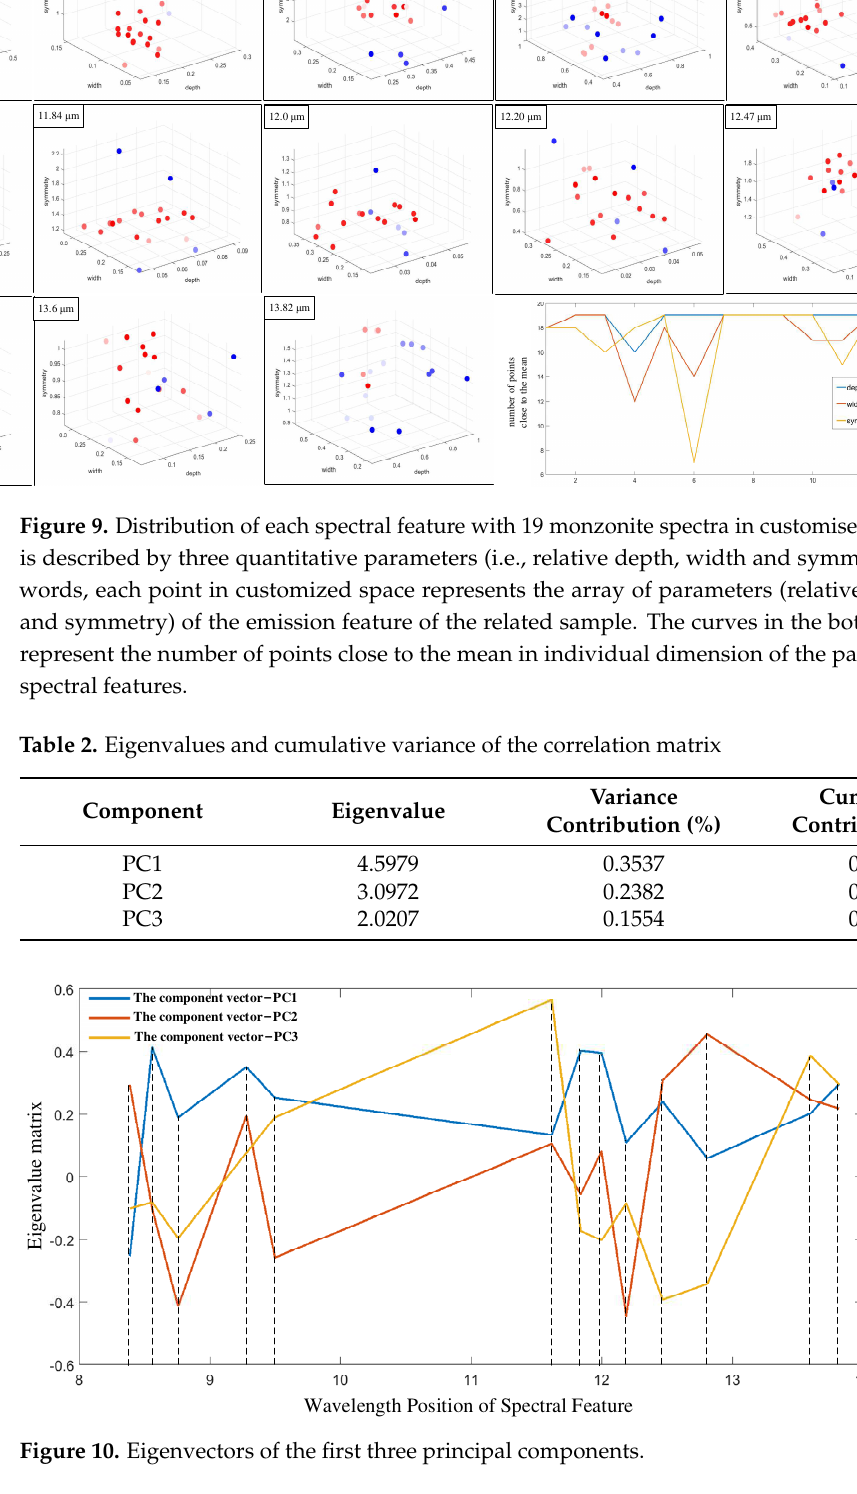
Figure 10. Eigenvectors of the first three principal components.